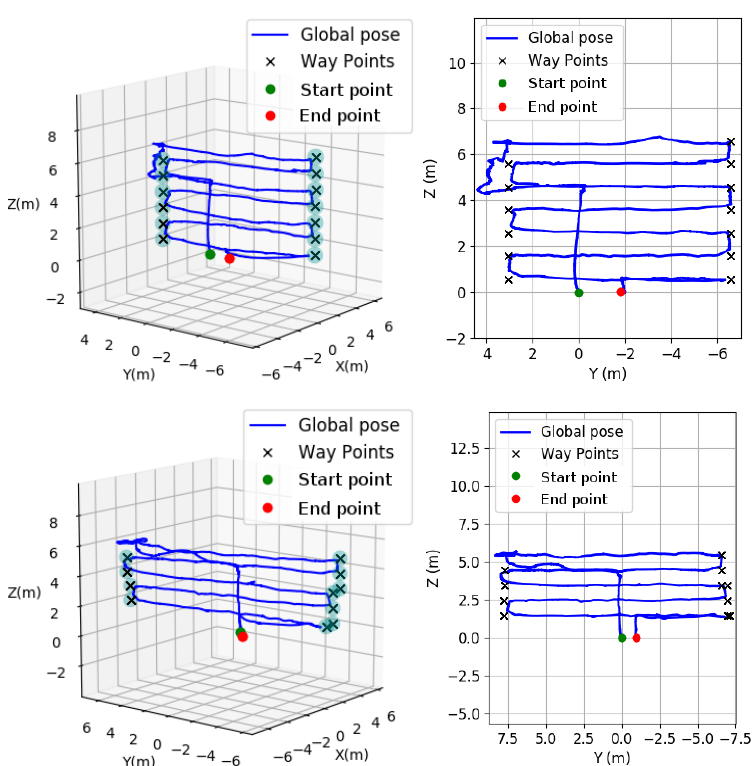
Figure 17. Autonomous sweepings of 10 × 6 m ( top ) and 15 × 4 m ( bottom ), descending 1 m between transects. In the plots, × in the center of a blue sphere denotes a way-point. (All units are in meters.).